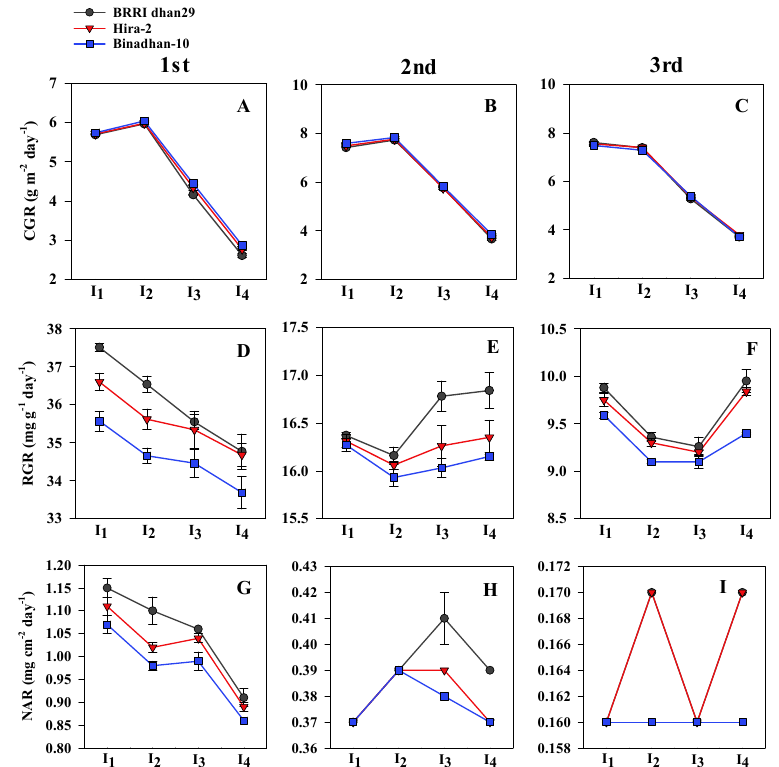
Figure 3. CGR, RGR and NAR of three rice cultivars at four irrigation regimes at 20–40 DAT (1st), 40–60 DAT (2nd) and 60–80 DAT (3rd). I 1 —continuous flooding, I 2 —Saturation, I 3 —75% of saturation, I 4 —50% of saturation. ( A – C ) represent CGR; ( D – F ) represent RGR; ( G – I ) represent